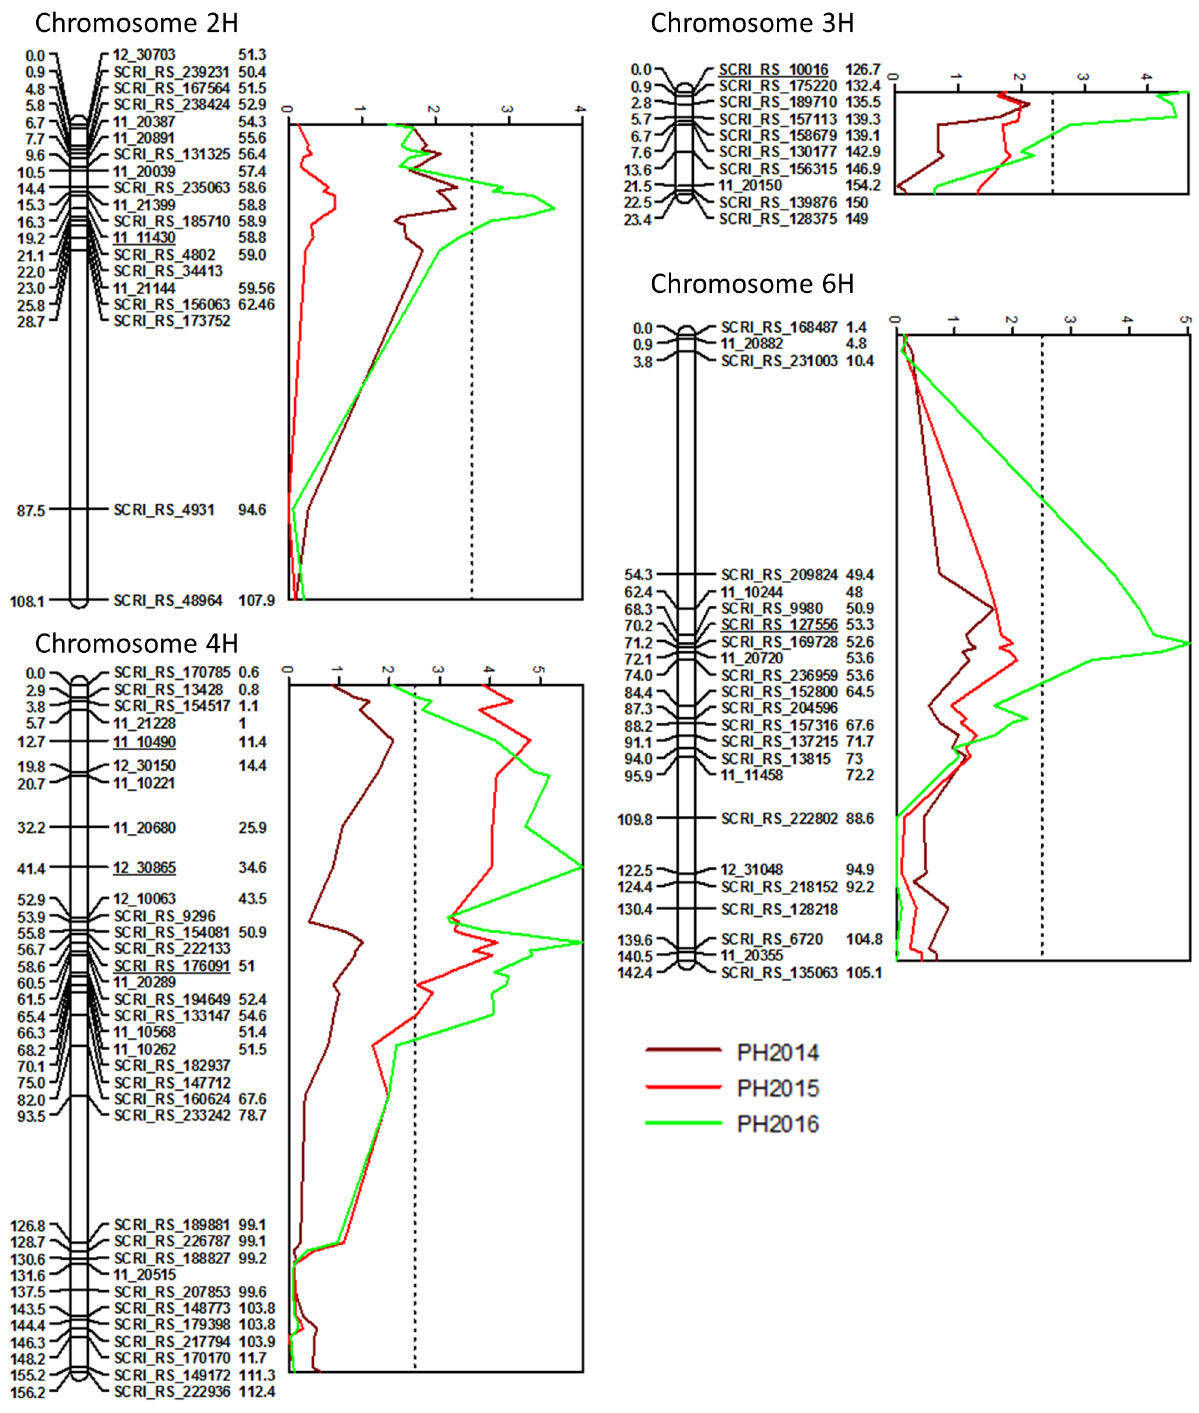
Fig 4. Chromosomes with significant QTL for PH in the Arve x Lavrans population with LOD curves obtained with interval mapping. Genetic distances on the AxL map are given in cM on the left side of the linkagemap bars. The numberson the right side of the marker names refer to the POPseq position of the marker [25]. Only one marker per positionwas kept. The dashed lines indicatethe LOD thresholdof 2.5 determinedby permutationtest.